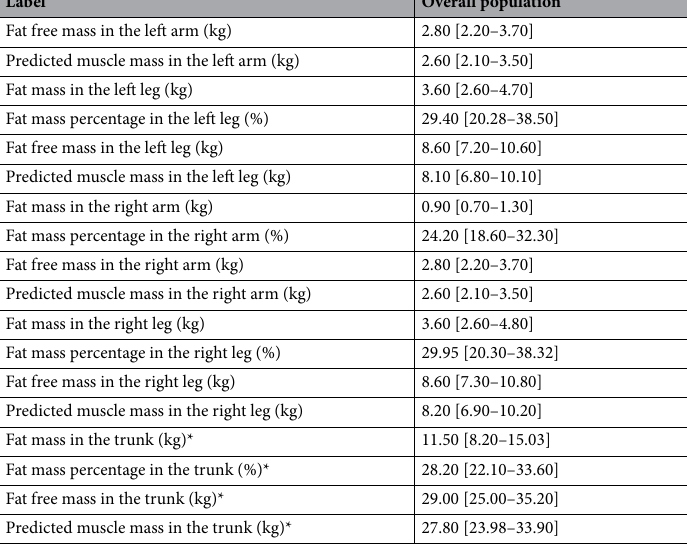
Table 1. Study characteristics in the overall population. (ORISCAV-LUX 2 study, N = 1356). *Features used in the cluster